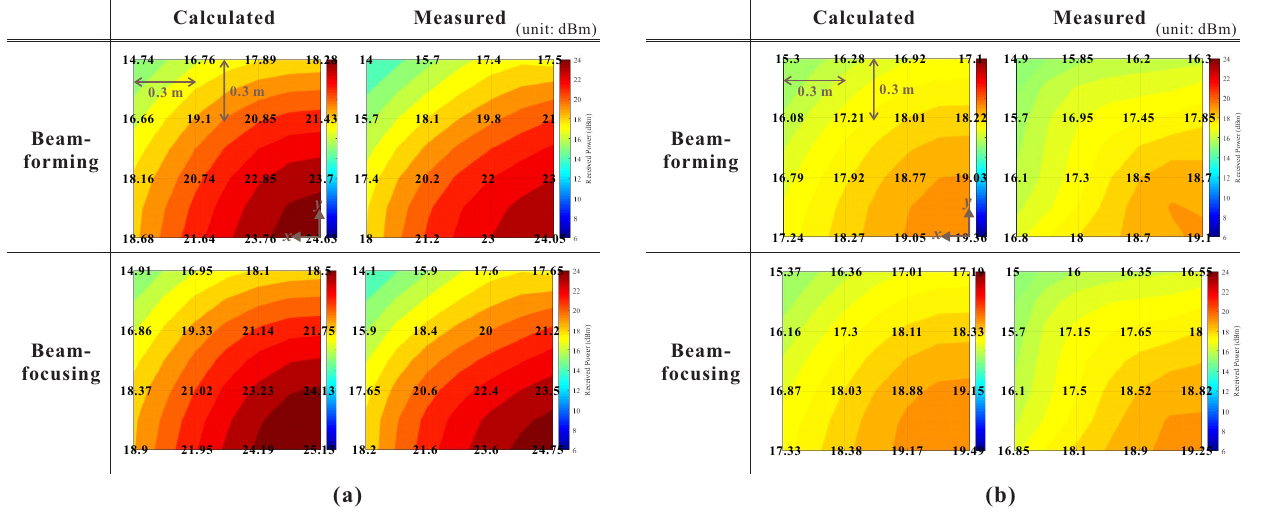
Figure 17. Distribution of the 2.482 GHz received power according to the Rx position: ( a ) distance = 1 m; ( b ) distance = 2 m. As a result of the 5.73 GHz WPT experiment, Figure 18a,b shows the received power distribution when the Rx antenna, as in Figure 2b, is moved on a virtual plane at